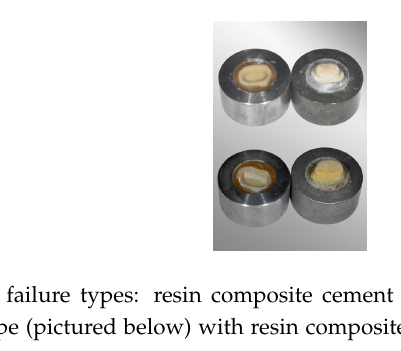
Figure 3. Estimated cumulative failure functions of specimens bonded with RelyX Ultimate.